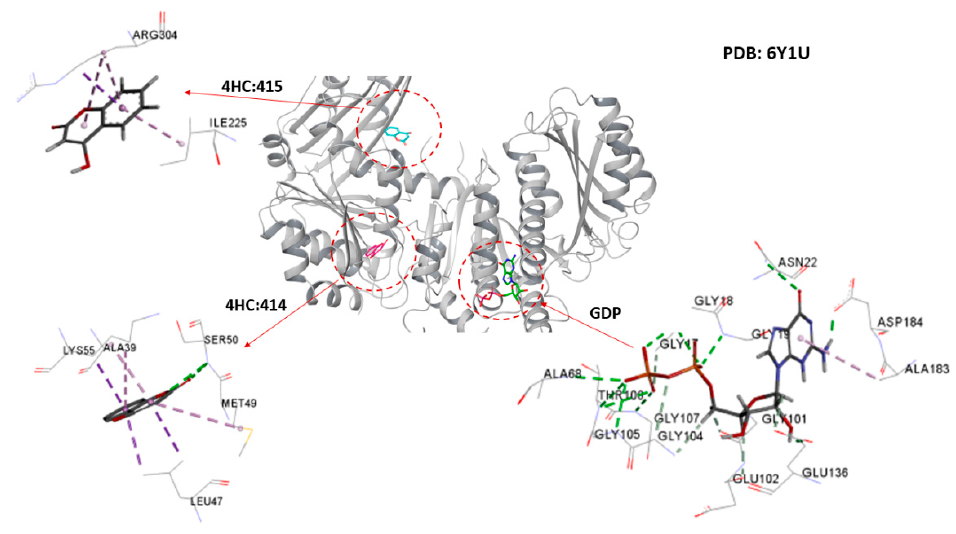
Figure 7. Binding site residues of FtsZ in complex with GDP nucleotide moiety and 4-hydroxycumarin ligand in the active site and two allosteric sites studied by Alnami et al. [26]. Table 3. Summary of the binding affinities of co-crystalized GDP, 4-hydroxycumarin in two different allosteric sites and cinnamaldehyde in terms of docking scores and glide energies generated by GLIDE XP